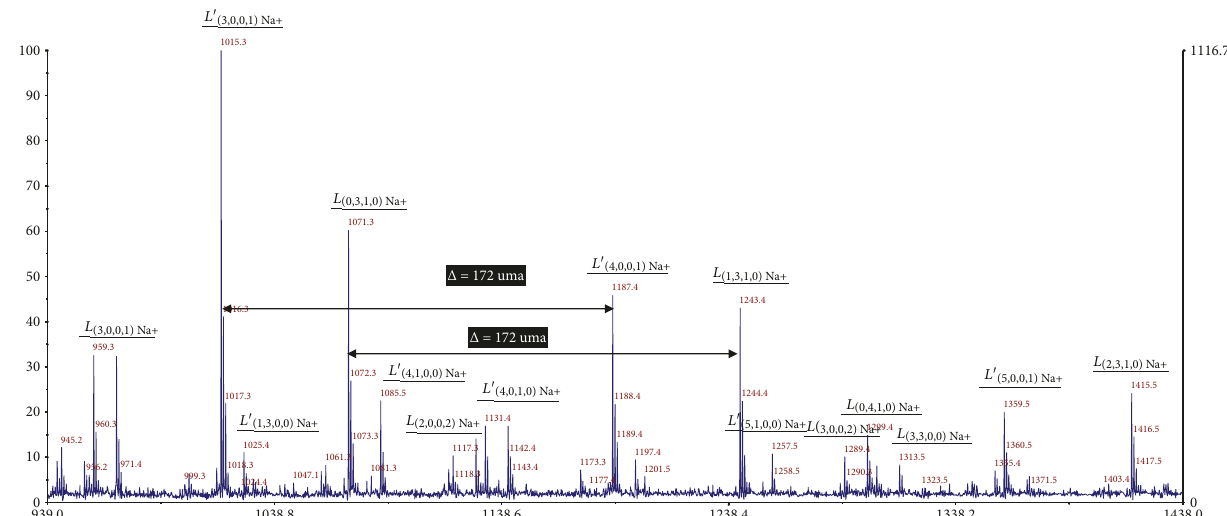
Figure 12: The MALDI-TOF MS spectrum of PBISu Ss . L n , m , y , z corresponds to linear species oligomer containing 1,4-butanediol end 70 30 groups with n and y succinate and sulfonated repeating units associated to 1,4-butanediol, m and z succinate and sulfonated repeating units associated to isosorbide. L n , m , y , z ′ corresponds to linear species oligomer containing isosorbide end groups with n and y succinate and sulfonated repeating units associated to the 1,4-butanediol, m and z succinate and sulfonated repeating units associated to